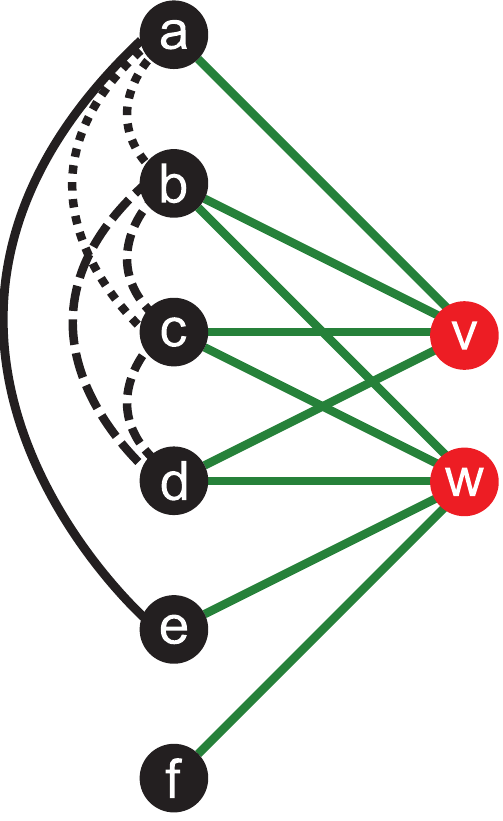
Figure 4. Features based on different edge sets between the exclusive, joint, and common neighborhoods of v and w . All left- hand nodes belong to the joint neighborhood of v and w . a is exclusive to v , while e , f are exclusive to w , and b , c , d are common neighbors of both. Our features comprise the absolute number of edges between common neighbors (black, dashed edges), exclusive neighbors (black, straight edge), joint neighborhood (all black edges between nodes a , b , c , d , e ), and an exclusive and a common neighbor (black, dotted edges). For each of them we also added their normalized value. Normalization was done by the number of possible edges between the neighbors they have.